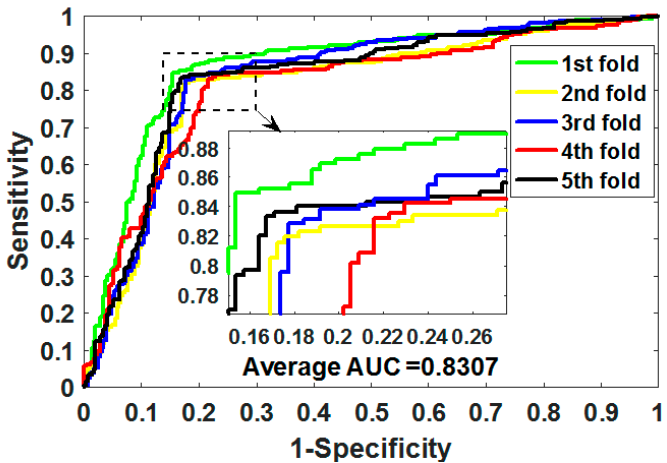
Figure 6. ROC curves plotted by the 2DPCA descriptor model on ion channel.